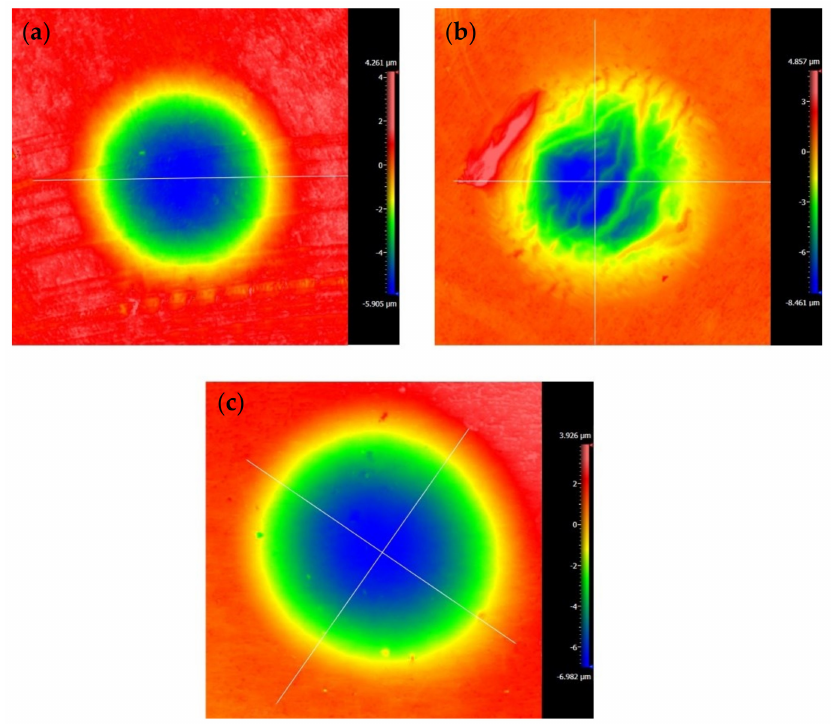
Figure 10. The profile of wear scars of PVDF thin films with F n = 15 N, ƒ = 15 Hz, and V c = 0 V: ( a ) D = ± 5 µ m, ( b ) D = ± 15 µ m, and ( c ) D = ± 40 µ